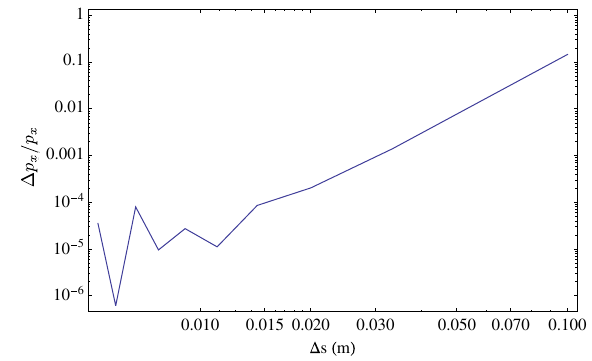
FIG. 5. Convergence of integration. Final p x error produced with WFR integration with varying step size compared with integra- tion with step size 0.5 mm. Initial conditions ð x; p x ; y; p y ; δ Þ ¼ 0 , z ¼ 0 . 01